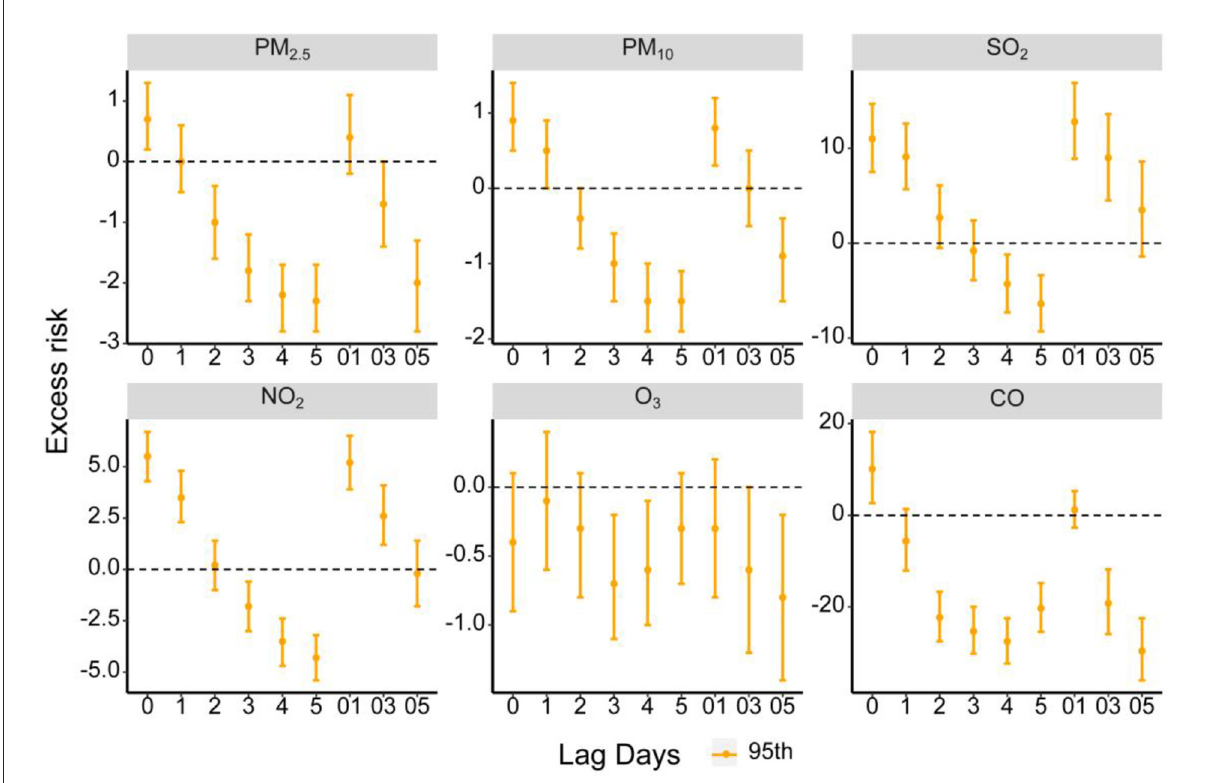
FIGURE1 Excess risk (ER, %) and 95% confidence intervals (CIs) for AD of each air pollutant along different lag days in Chongqing,